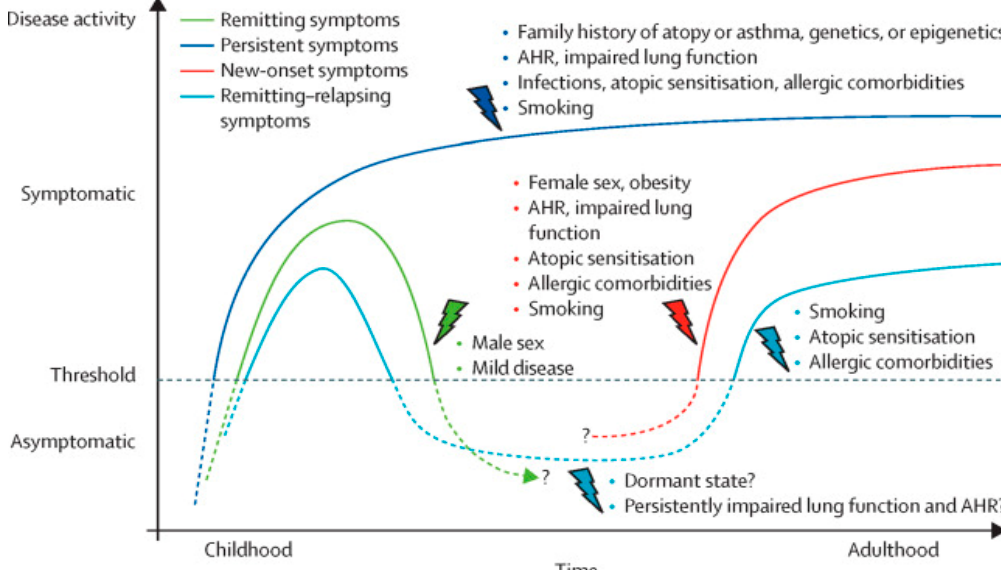
Figure 2. Determinants of disease course across asthma transition and ages. The figure displays putative determinants that affect the disease course of different asthma phenotypes by course and time of onset of symptoms. AHR: airway hyper-responsiveness. Reprinted with permission from Elsevier from [5].